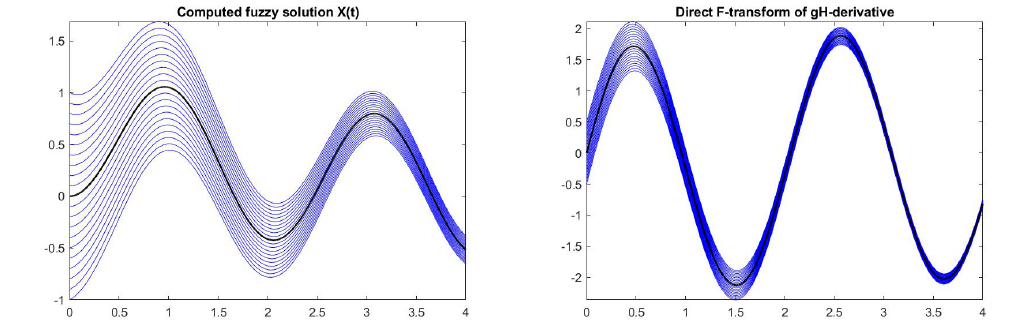
Figure 14. Problem FDE1, Meth = 2: Fuzzy-valued gH-differentiable solution ( left ) and its gH-derivative ( right ). For all α -cuts, there are no switching